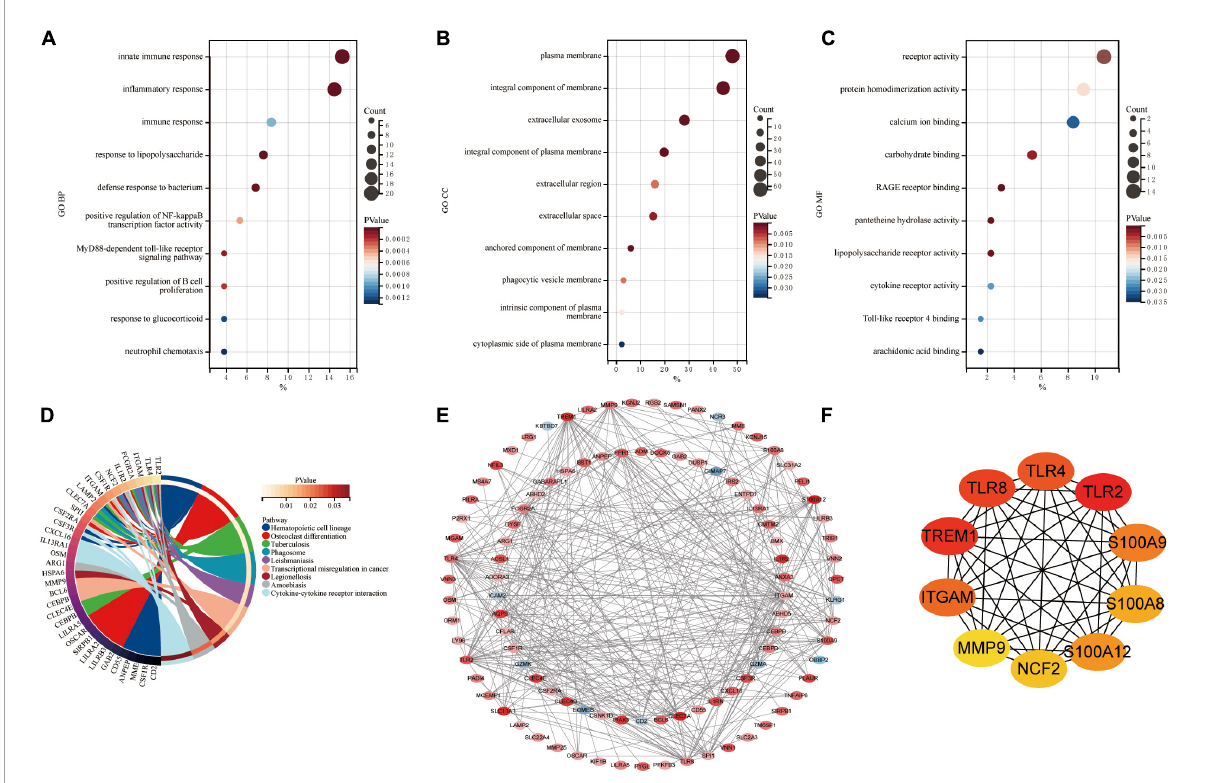
FIGURE3 Enrichment analysis and PPI analysis of CoDEGs. (A) Bubble plot of biological process (BP; TOP10). (B) Bubble plot of cellular component (CC; TOP10). (C) Bubble plot of molecular function (MF; TOP10). (D) Circle plot of KEGG pathway enrichment analysis (TOP10). (E) The whole PPI Network. The 91 orange red nodes in the network represent up-regulated genes and the 10 blue nodes in the network represent down-regulated genes. (F) The top 10 genes predicted by the MCC